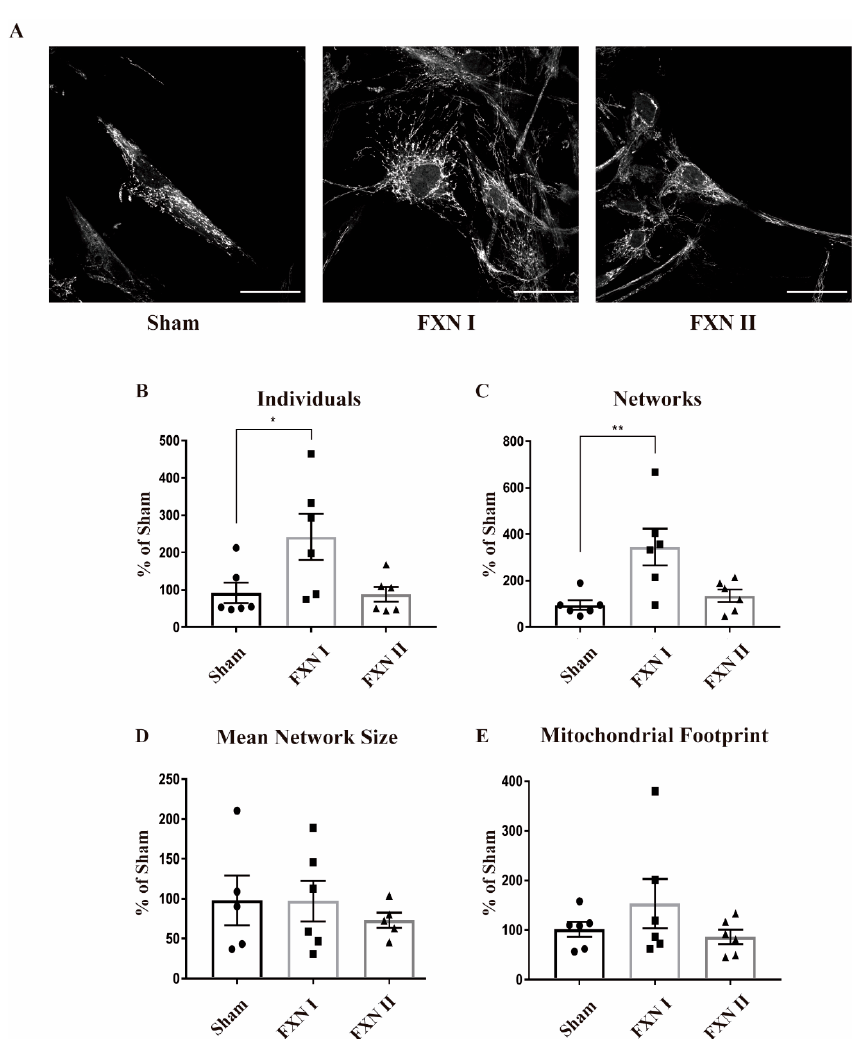
Figure 3. Mitochondrial network analysis in OEMS FRDA patient cells after lentiviral transduction with frataxin isoforms. All cells were stained with Mitotracker and then analyzed by MiNA (Fiji). ( A ) OE-MS patient cells either left non-transduced (left), or transduced with Lv-FXN I (middle) or Lv-FXN II (right) and stained with Mitotracker. Calibration bar represents 50 µ m. ( B ) to ( E ) Analysis and quantification of OE-MSc mitochondrial network morphology with MiNA. ( B ) Percentage of raw number of individual mitochondria. ( C ) Percentage of mitochondria arranged in a networked junctioned structure. ( D ) Number of branches per knot. ( E ) Total mitochondrial footprint, indicating the quantity of signal versus background in the image. Data represents mean ± SEM of at least three independent cell culture preparations ( n = 3). Data were analyzed by one-way ANOVA test with post hoc Dunnett multiple comparisons test. * p < 0.05; ** p <